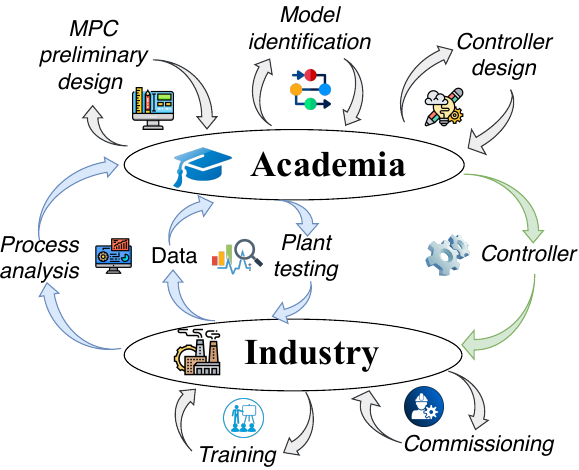
Figure 5. The process diagram of the proposed MPC transfer from academia to